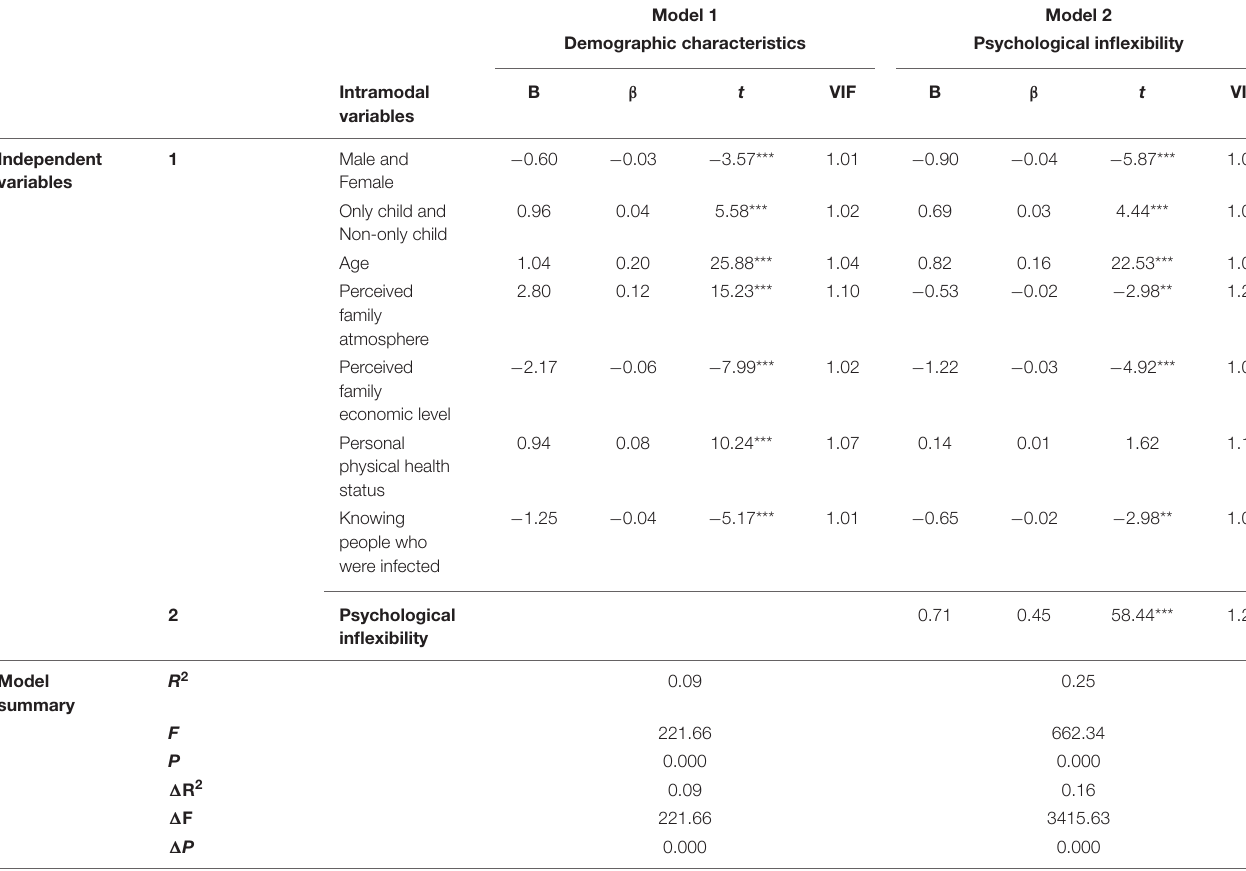
TABLE 3 | Hierarchical multiple regression analyses using the CRIES-13 total score for adolescents as the outcome